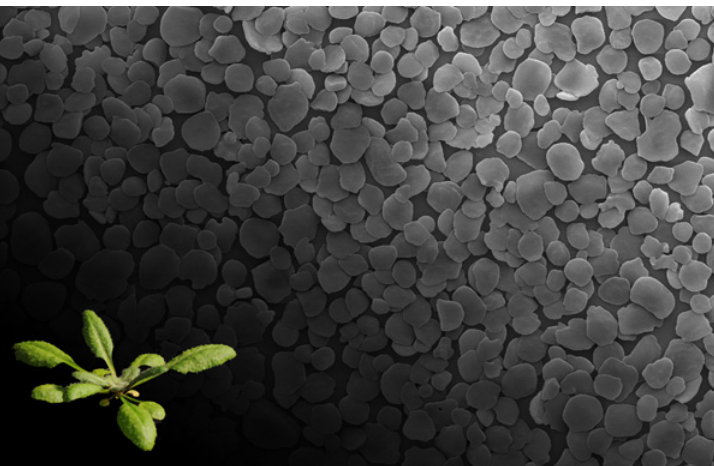
Fig 1. Starch granules are produced as a carbohydrate reserve in plants, including the model plant A. thaliana